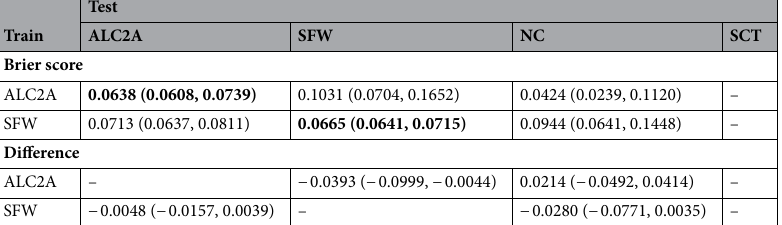
Table 5. Model 2 (Saliva DNA) Brier scores and Brier scores differences for the test and training data sets. * Bolded numerical entries are the Brier scores for which the training and test data are identical. **95% CI intervals for Brier Scores and differences are given in